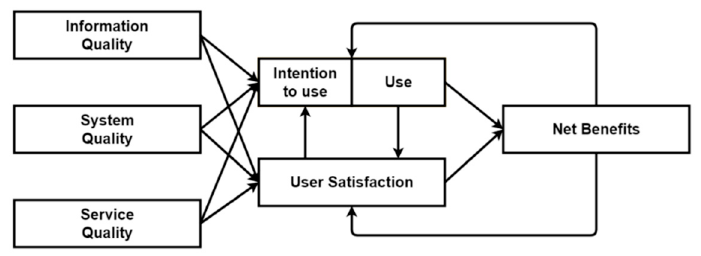
Figure 2. Updated Information System Success Model [32].